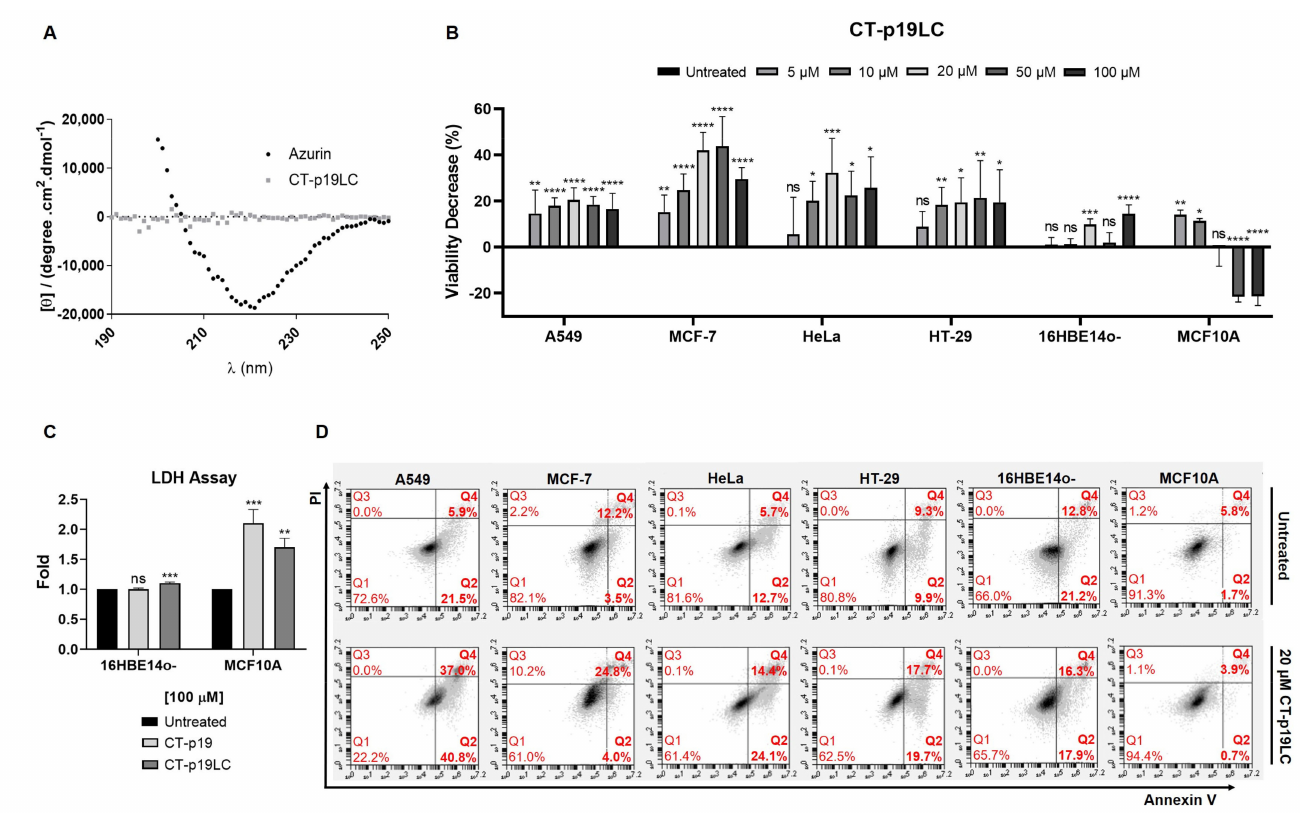
Figure 3. Cytotoxic effect of newly designed CT-p19LC peptide: ( A ) circular dichroism spectra of azurin and CT-p19LC (5 µ M) in sodium phosphate buffer 10 mM, pH 7.4, at 25 ◦ C; ( B ) viability decrease (100% of proliferation in untreated condition—% of proliferation for each treatment condition) of A549 (lung), MCF-7 (breast), HeLa (cervix) and HT-29 (colorectal) cancer cells and 16HBE14o- (bronchial) and MCF10A (mammary gland) non-cancer cells when incubated with different concentrations of CT-p19LC peptide (0 to 100 µ M) over 48 h. Untreated condition (control) consisted of cells incubated with medium only. Values represent the means ± SD, and each condition had at least n = 3. *, **, ***, **** and ns denote significant differences of p < 0.1, p < 0.01, p < 0.001 and p < 0.0001 and differences that were not statistically significant, respectively, when comparing control with treatments; ( C ) LDH assay in non-cancer cell lines treated with 100 µ M of CT-p19 and CT-p19LC. Values represent the means ± SD (n = 3). **, *** and ns denote significant differences of p < 0.01 and p < 0.001 and differences that were not statistically significant, respectively, when comparing treatments with control; ( D ) apoptosis assay in cancer and non-cancer cells treated with 20 µ M of CT-p19LC for 48 h, assessed by flow cytometry. Representative figures showing a population of viable cells in the left lower quadrant (Q1; annexin V − /PI − ), early apoptotic cells in the right lower quadrant (Q2; annexin V+/PI − ), necrotic cells in the left upper quadrant (Q3; annexin V − /PI+) and advanced apoptotic or necrotic cells in the right upper quadrant (Q4; annexin